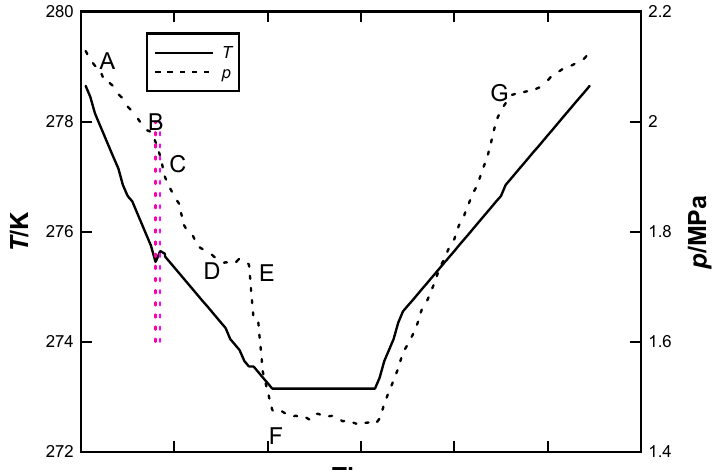
273 273.5 274 274.5 275 275.5 276 276.5 277 277.5 278 T /K hydrate in Figure 5. Typical curves of pressure and temperature changes with time for CO 2 the mixed glass beads and silica gel: the broken line represents the value of pressure and the solid line indicates the temperature in the vessel.